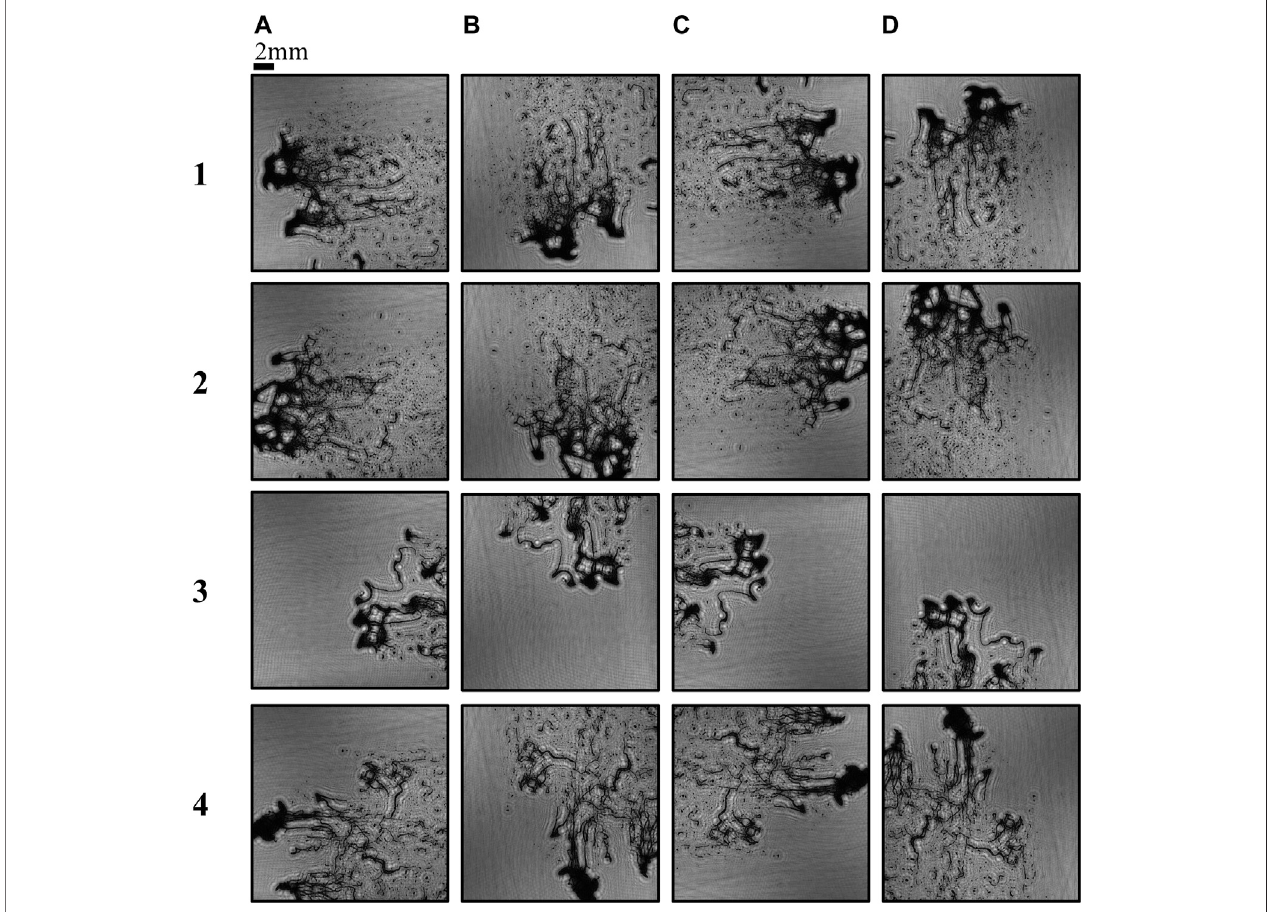
FIGURE 6 | Dataset with data augmentation. The subgraphs (1) to (4) in column (A) are the original images chosen randomly from the dataset which has been cropped into 672 × 672. The column (B) to D refer to the augmented images generated by rotating the original images by 90 ° ,180 ° and 270 ° respectively.